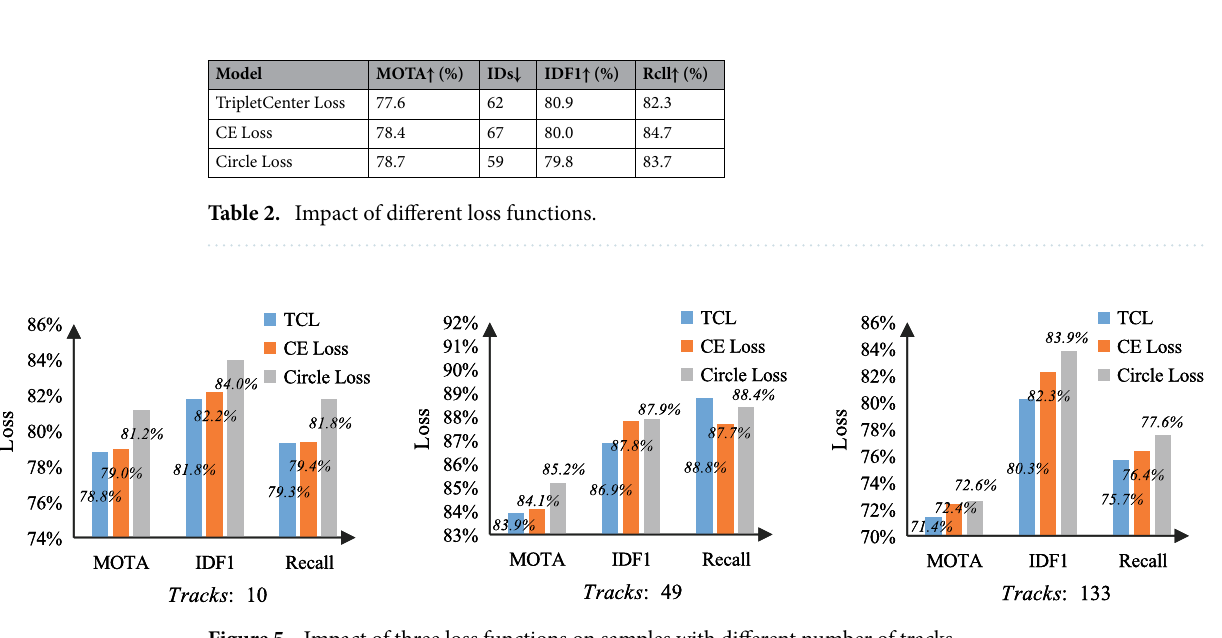
Figure 5. Impact of three loss functions on samples with different number of